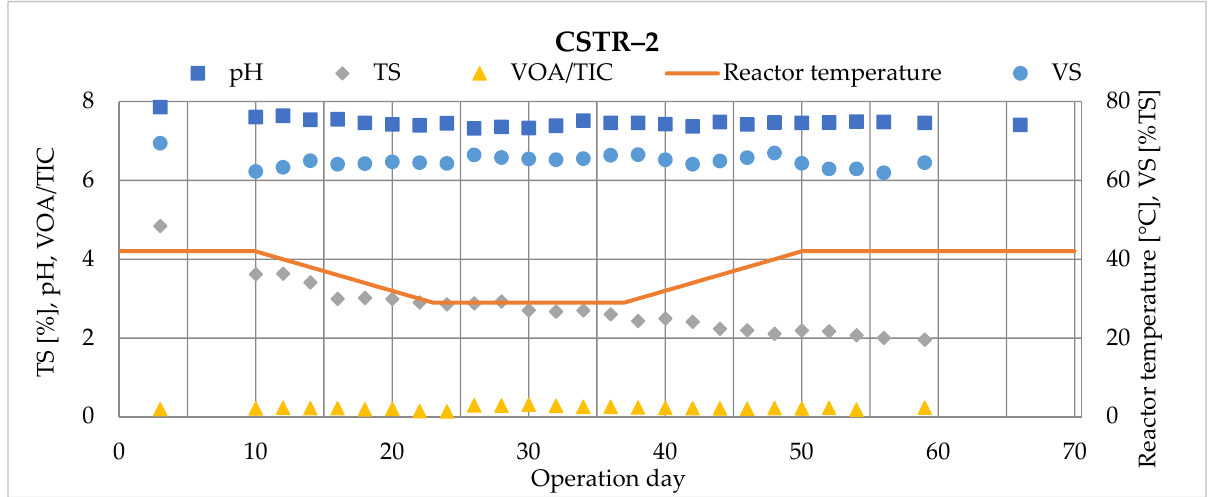
Figure 10. Results of laboratory analyses in CSTR-2.